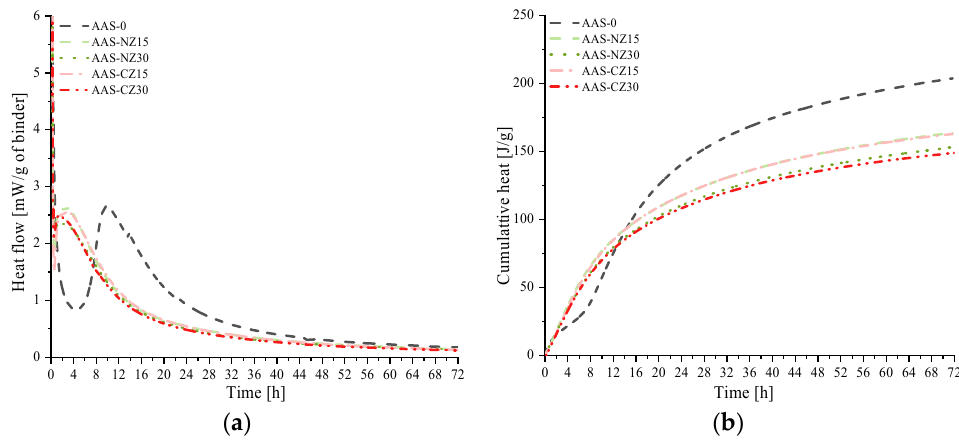
Figure 5. Isothermal calorimetry curves of the AAS mortar specimens for 3 days: ( a ) Heat flow curves; ( b ) cumulative heat curves.